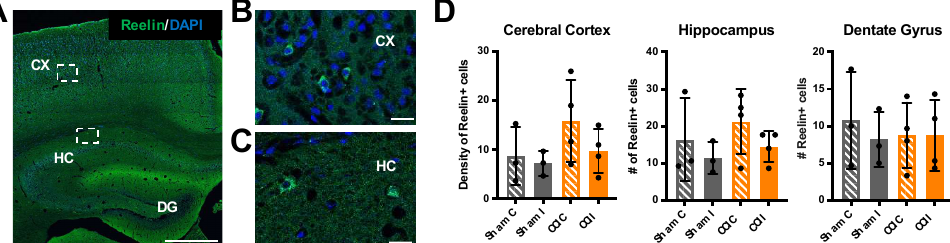
Figure 2. No change in the number of Reelin+ cells 24 h post-CCI. ( A ) Low magnification image of a CCI contralateral brain section immunolabeled with Alexa Fluor 488-conjugated Reelin monoclonal antibodies (green) and counterstained with DAPI (blue). ( B ) High-magnification image of the cerebral cortex (CX) corresponding to the inset in ( A ). ( C ) High-magnification image of the hippocampus (HC) corresponding to the inset in ( A ). CX = cerebral cortex; HC = hippocampus; DG = dentate gyrus. Scale bars: 500 µ m ( A ) and 20 µ m ( B and C ). ( D ) Quantification of Reelin + cells from n = 3 sham and n = 4 CCI mice. Each value is the average of three di ff erent sections / brain. Data in the cerebral cortex represent the average density of Reelin+ cells (number of cells/six regions of interest (ROIs)), whereas data in the hippocampus and dentate gyrus represent the total number of cells counted in the entire structure. Statistical analysis was conducted comparing contralateral (C) to ipsilateral (I) values in each sham or CCI group using paired t -tests. The number of Reelin+ cells was not significantly affected by CCI or sham surgery. Scatter dot plots show individual data points and the mean values +/- SD.